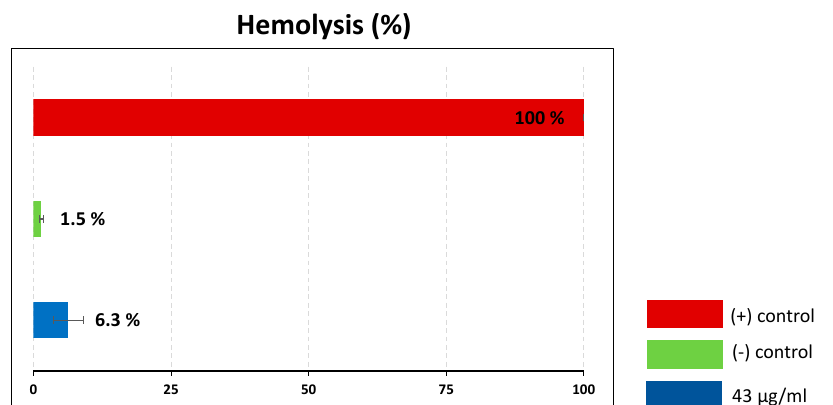
Figure 7. Hemolytic activity of Rhynocoris iracundus venom against porcine red blood cells. Relative